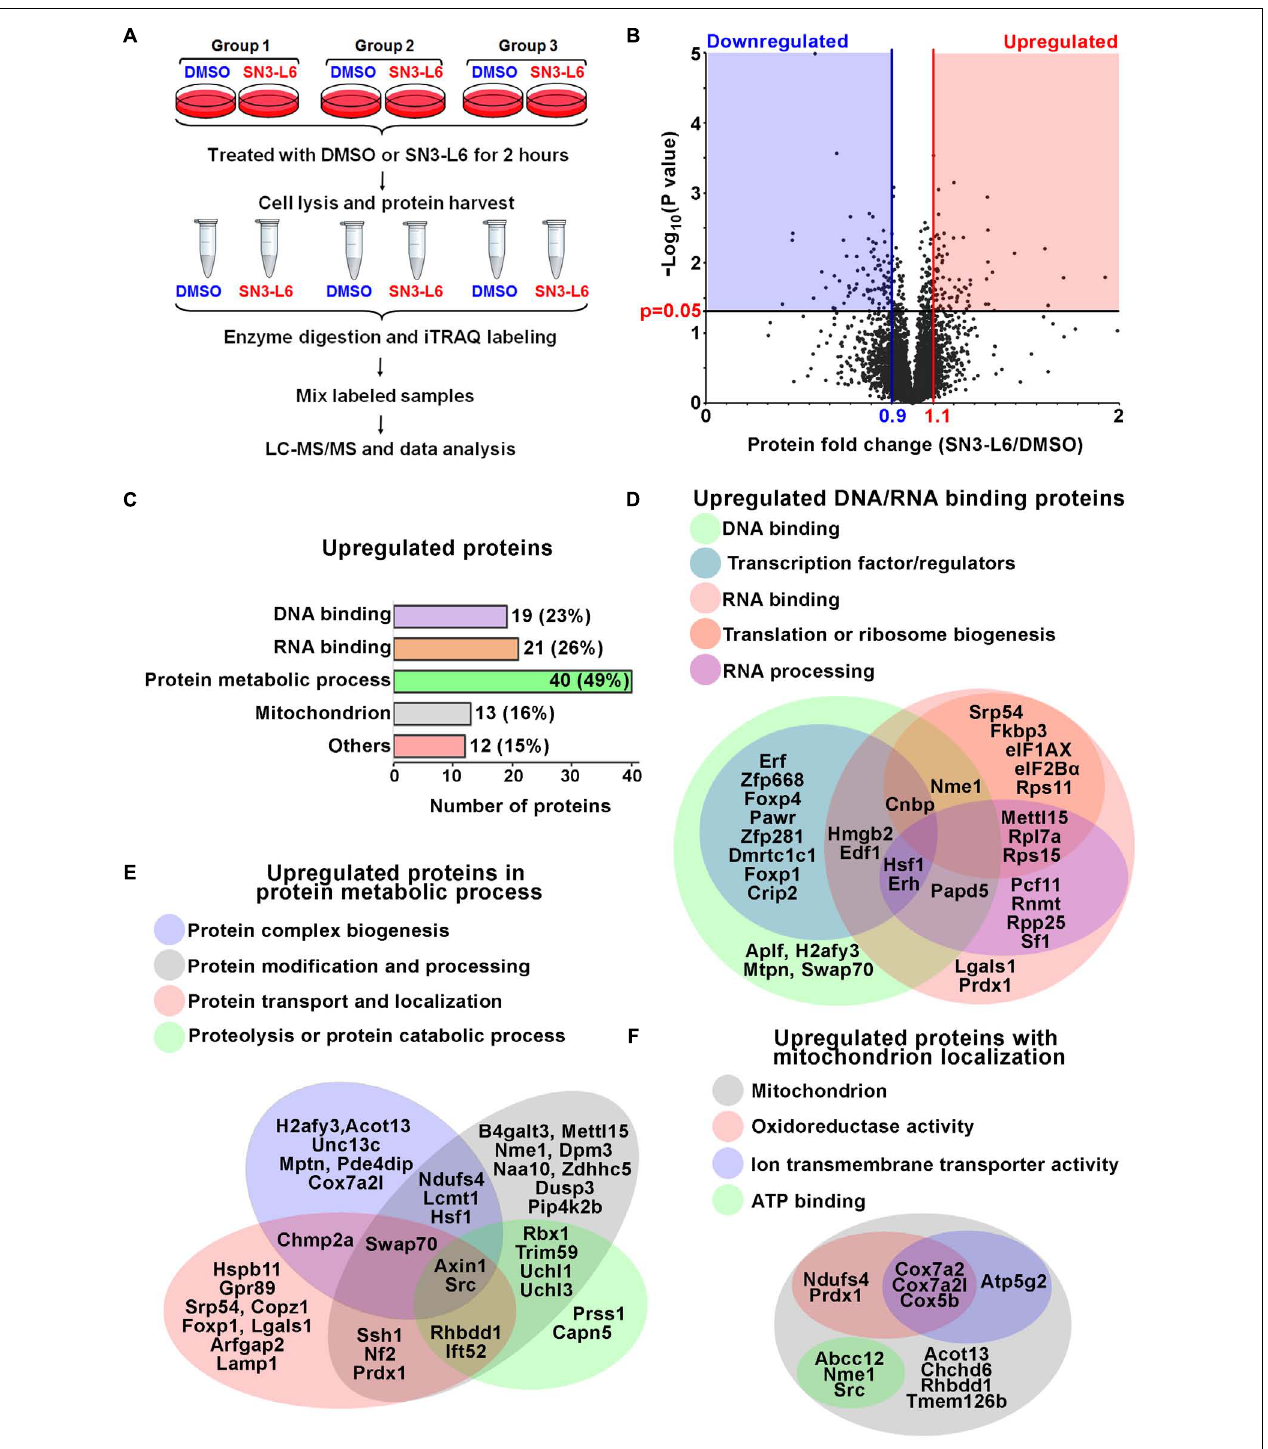
FIGURE 2 | SN3-L6 upregulates proteins in DNA and RNA binding, protein metabolism and mitochondrial localization. (A) A schematic of the experimental procedures for isobaric tag for relative and absolute quantitation (iTRAQ) analysis. (B) A Volcano plot is drawn to show the distribution of all proteins identified by LC-MS/MS. Upregulated and downregulated proteins are defined by 1.1- and 0.9-fold change, respectively, with P -value smaller than 0.05 (distributed in red and blue areas of the plot, respectively). (C) Numbers of proteins that are involved in DNA binding, RNA binding, protein metabolic process and mitochondrion localization. Venn diagrams are drawn to show classifications of individual proteins involved in DNA and RNA binding (D) , protein metabolic process (E) , and mitochondrion localization (F) .